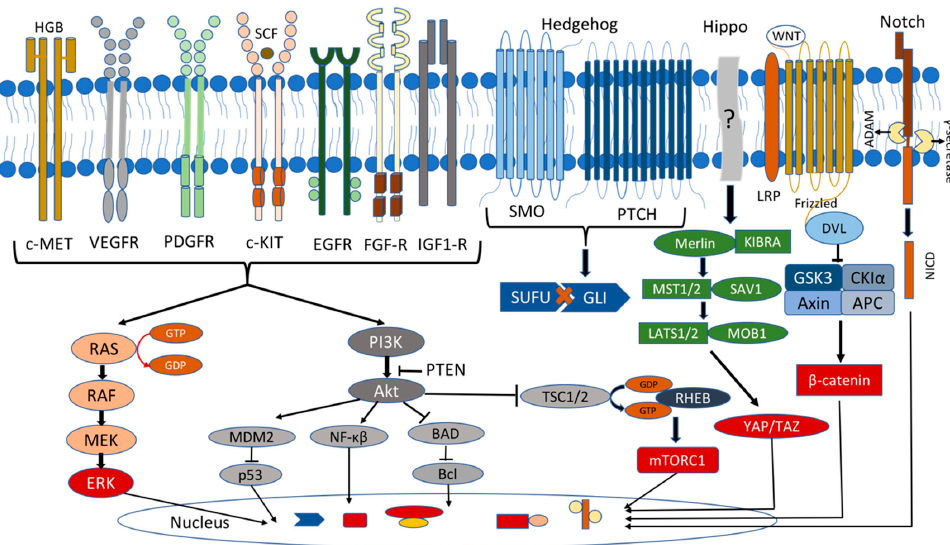
Figure 2. Molecular pathways involved in pituitary tumorigenesis. Growth factor signaling (recep- tor tyrosine kinases e.g., MET [103], KIT [104], PDGF [105], IGF-1, EGF, VEGF, and FGF receptor families [106]), Hippo signaling [17,107], Wnt signaling [108], Notch signaling [109], and